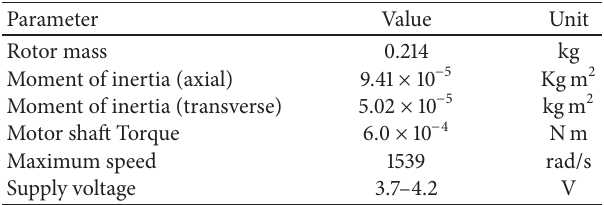
Figure 2: Overview of proposed ACS design for a CubeSat-class nanosatellite. Table 2: Reaction wheel